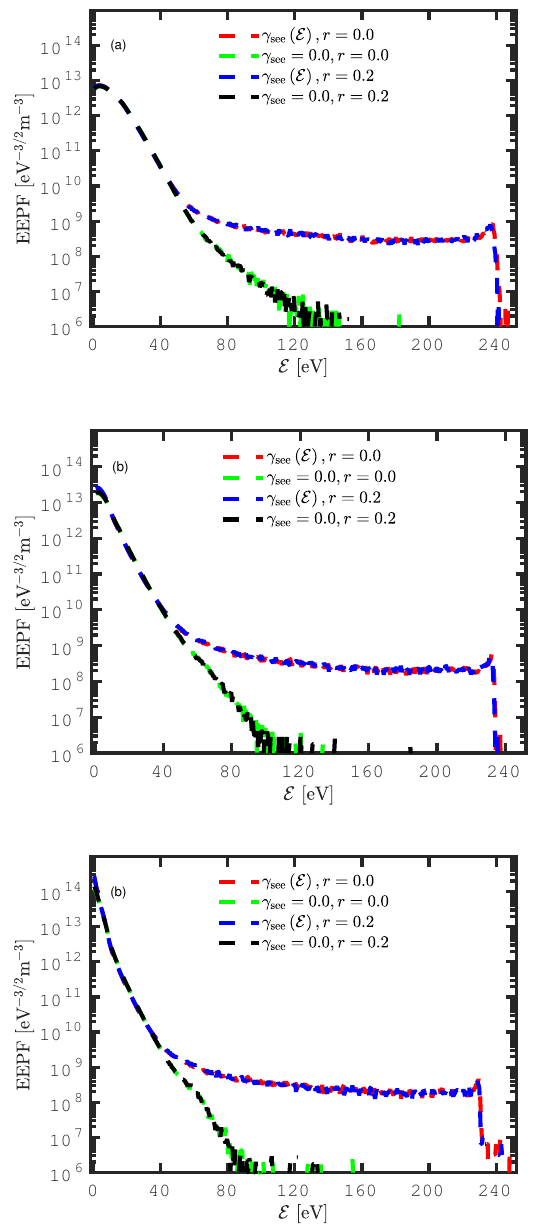
Figure 1. The electron energy probability function (EEPF) in the discharge center for a parallel plate capacitively-coupled oxygen discharge at ( a ) 10 mTorr, ( b ) 25 mTorr, and ( c ) 50 mTorr with a surface quenching coefficient for the singlet metastable molecule O 2 ( a 1 ∆ g ) as γ wqa = 0.0001 and a gap separation of 4.5 cm driven by a 222 V voltage source at a driving frequency of 13.56